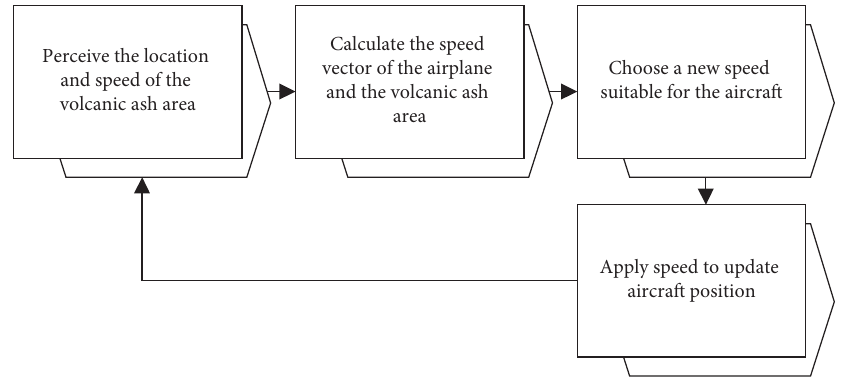
Figure 2: The cyclic process of the aircraft sensing the volcanic ash area and processing it.